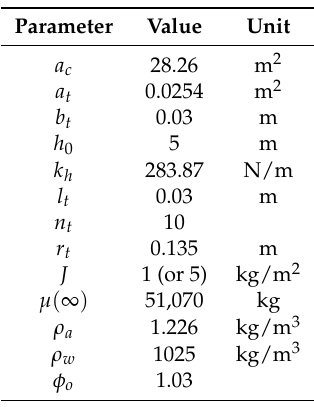
Table 1. Parameters and values in the